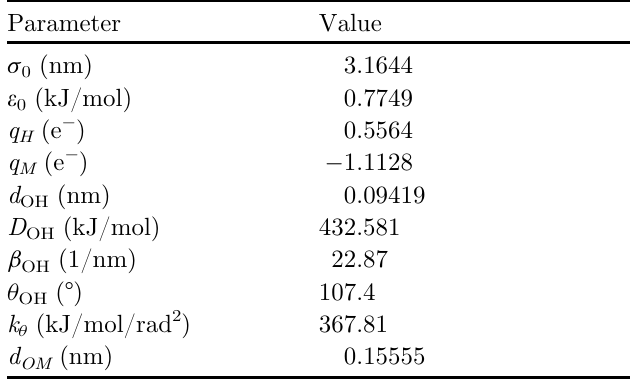
Table 1. Parameters of the TIP4P/2005f water potential [10] as used in the CAB model established in reference